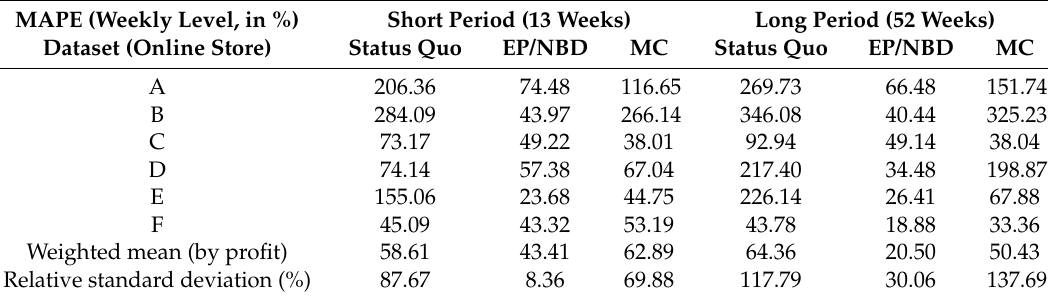
Table 4. Results for MAPE (weekly level, in